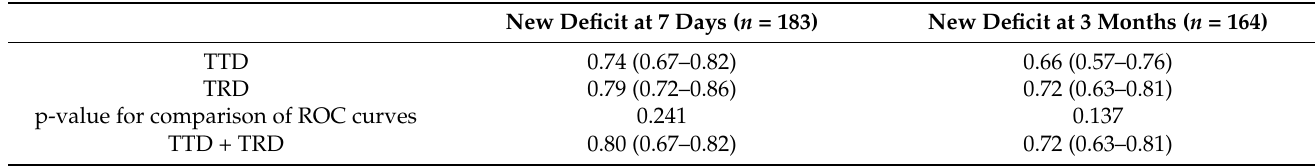
Figure 3. Bar chart for onset of new deficits among the TTD and TRD groups. The figure shows the development of persistent new deficits (defined as “worsened”) at three months among the different categories of TTD ( A ) and TRD ( B ), compared to patients with stable or improved deficits. The TRD seems to better discriminate the outcome according to CST infiltration. Table 3. AUC for new deficits in relation to TTD and